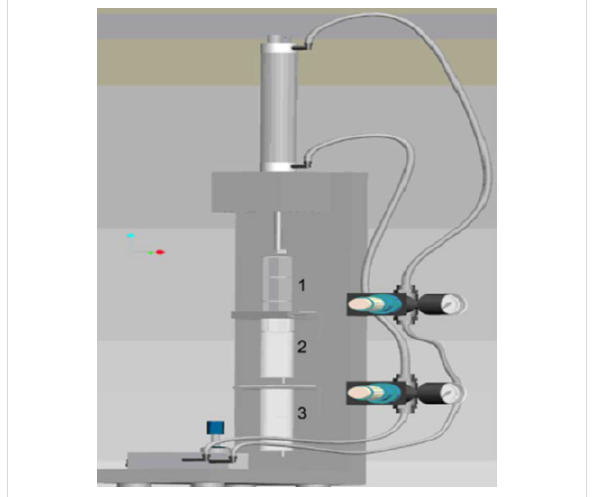
Figure 8: Schematic of a shearing device. Reproduced with permis- sion from [55], copyright 2007 Elsevier.